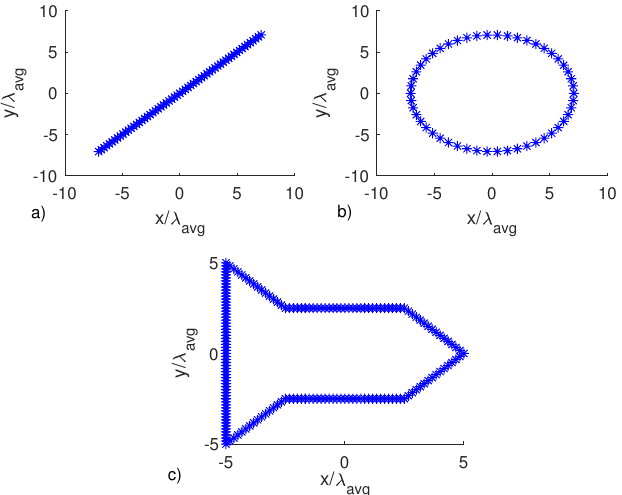
Figure 5. Contours of the objects under test.